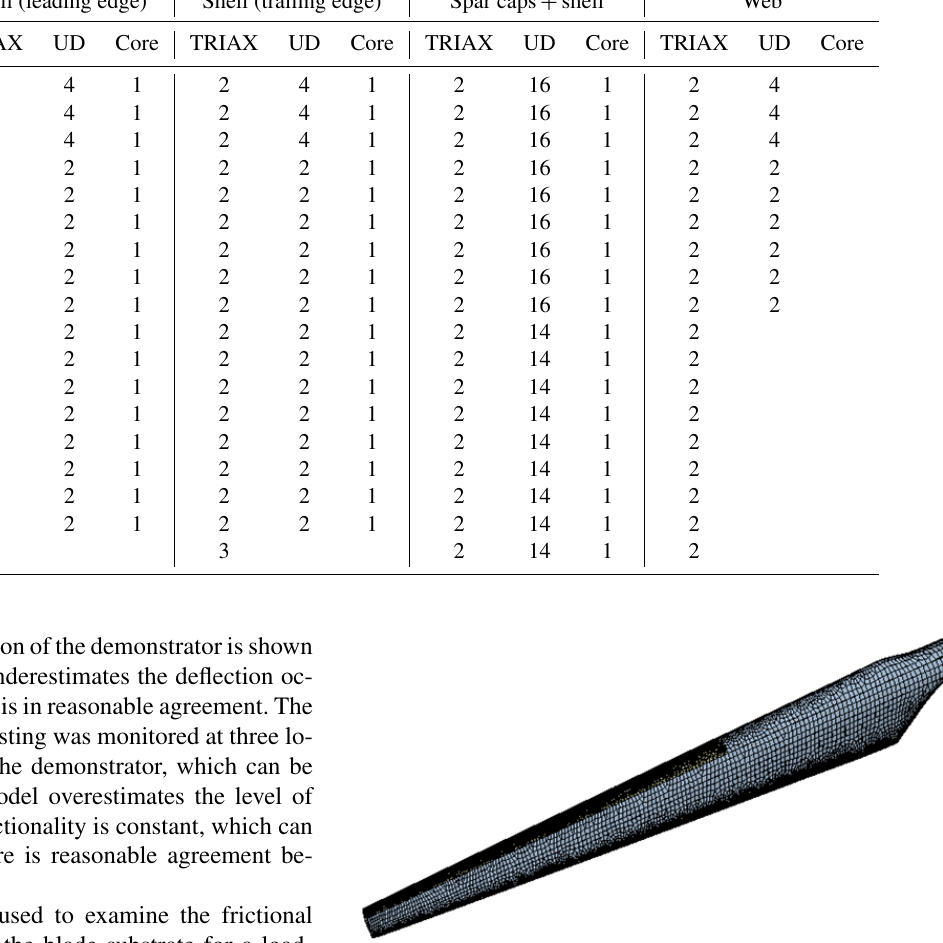
Table 2. Details of the composite ply lay-ups for the full-scale wind turbine blade. Blade length